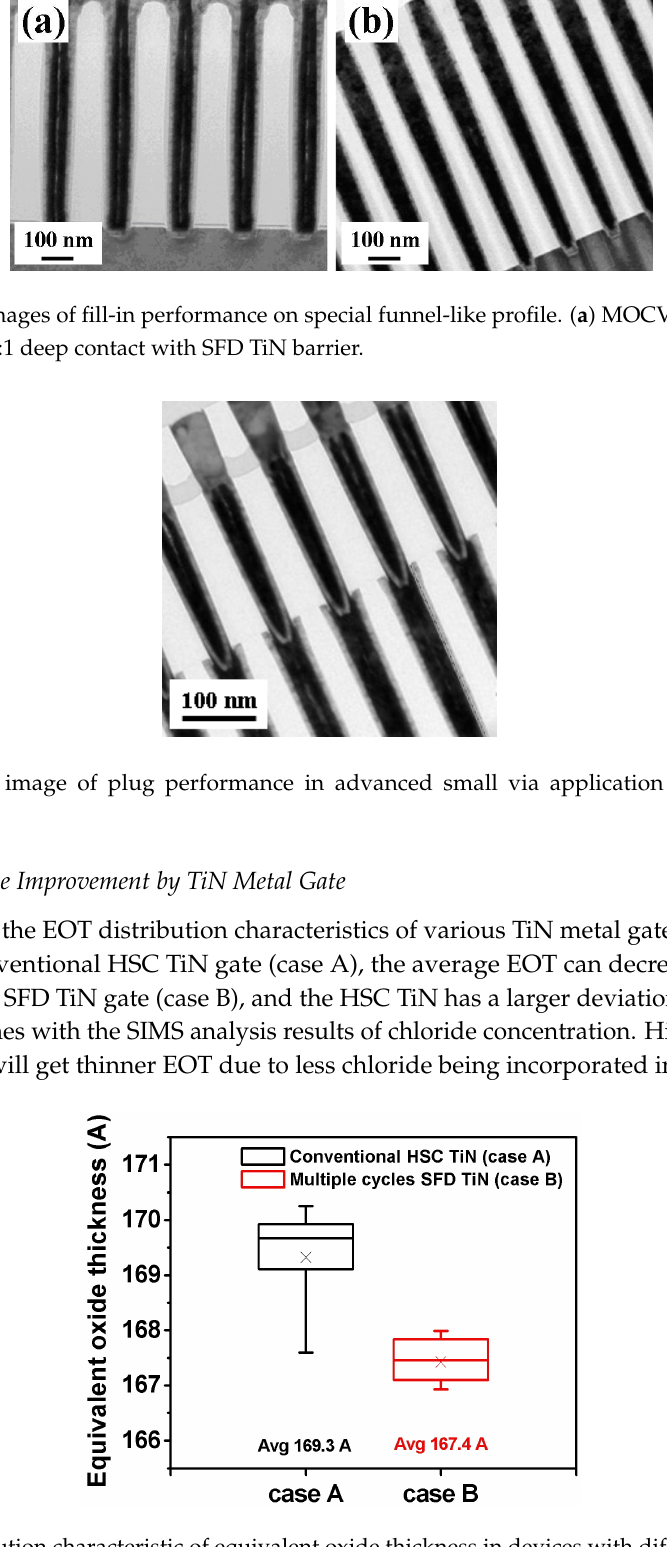
Figure 9. Distribution characteristic of equivalent oxide thickness in devices with different TiN gates.